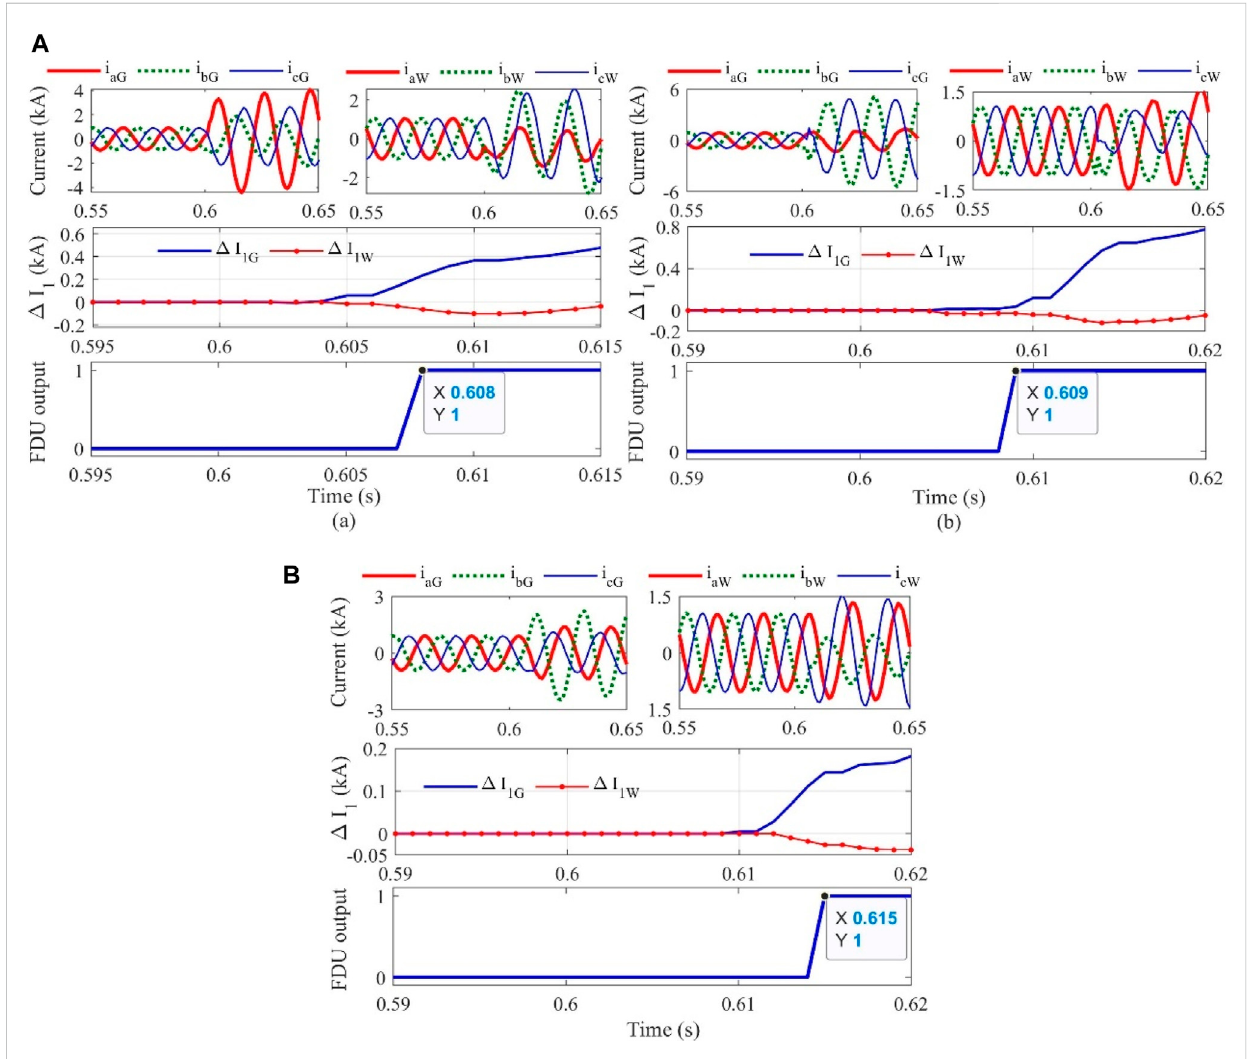
FIGURE 8 Results during (A) unbalanced fault, (a) ag-fault, (b) bc-fault and (B) high-resistance